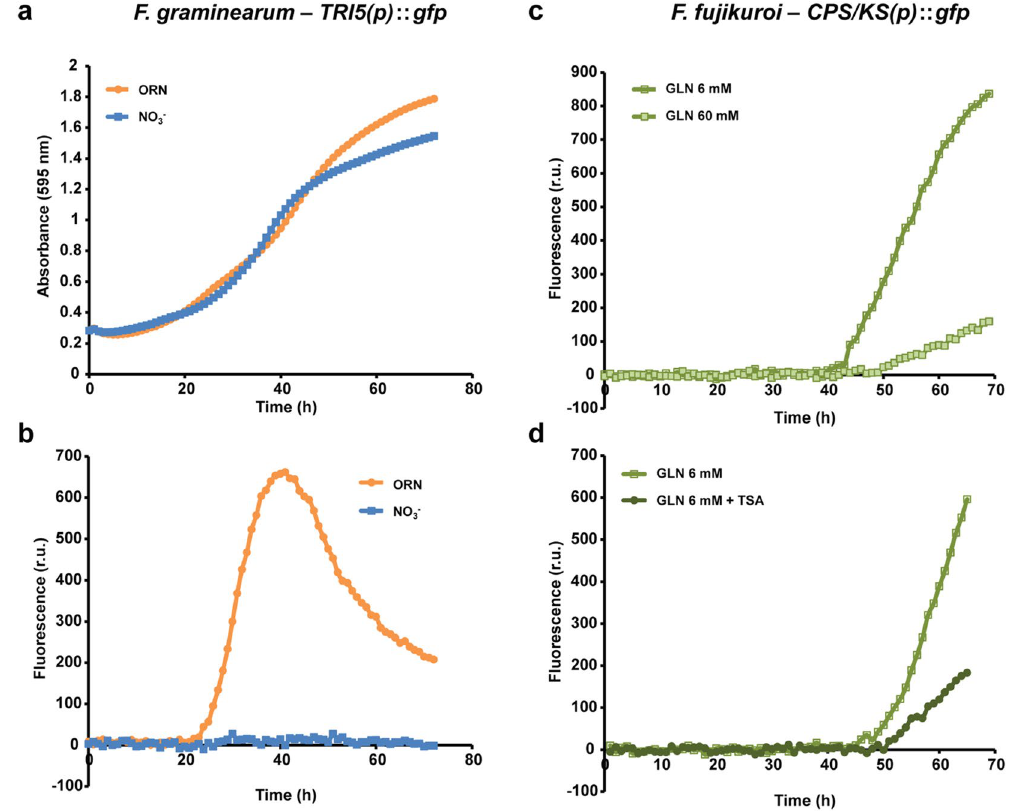
Figure 6. Monitoring expression of TRI5 ( p ) ::gfp and CPS/KS ( p ) ::gfp in F. graminearum and F. fujikuroi . ( a ) The F . graminearum wild-type strain was grown on solid Fusarium minimal medium (FMM) with either 5 mM L-ornithine (ORN, inducing conditions) or 50 mM nitrate (NO 3 − , repressing conditions) at 24°C up to 72 h. Absorbance at 595 nm was monitored every hour. ( b ) In parallel, TRI5 expression was quantified with the levels of GFP fluorescence. It was clearly detectable under inducing conditions, while fluorescence was not significantly detectable under repressing conditions. ( c ) The F . fujikuroi wild-type strain was grown on solid ICI medium with either 6 mM glutamine (GLN, inducing) or 60 mM glutamine (repressing) at 28°C up to 66 h. Fluorescence and hence CPS/KS expression is increased under inducing conditions compared to repressing conditions. ( d ) Addition of TSA to the culture media reduced the expression of CPS/KS grown under inducing conditions. Hyphal growth did not differ markedly between the different conditions (Supplementary Fig. 5). In all cases, data were acquired every one hour over the complete time course. The diagrams depict representative examples of the fluorescence patterns as the average from 3–4